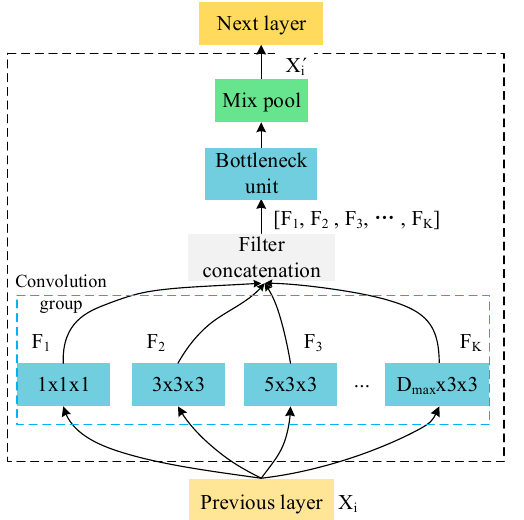
Figure 7. Msk with K branches. The blue rectangle represents convolution and the green rectangle represents maximum pooling.